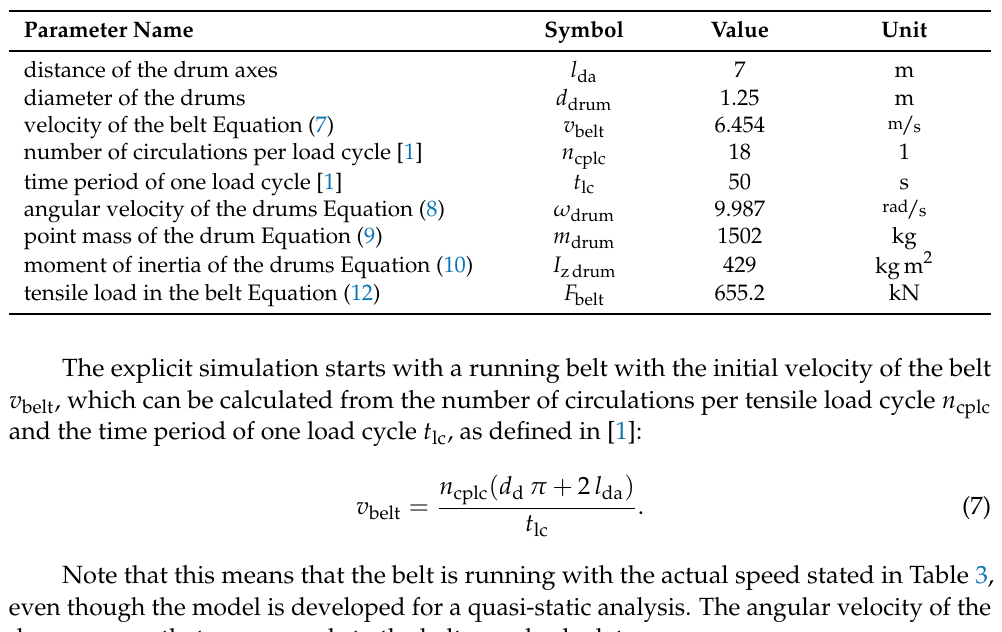
Table 3. Parameters of the test